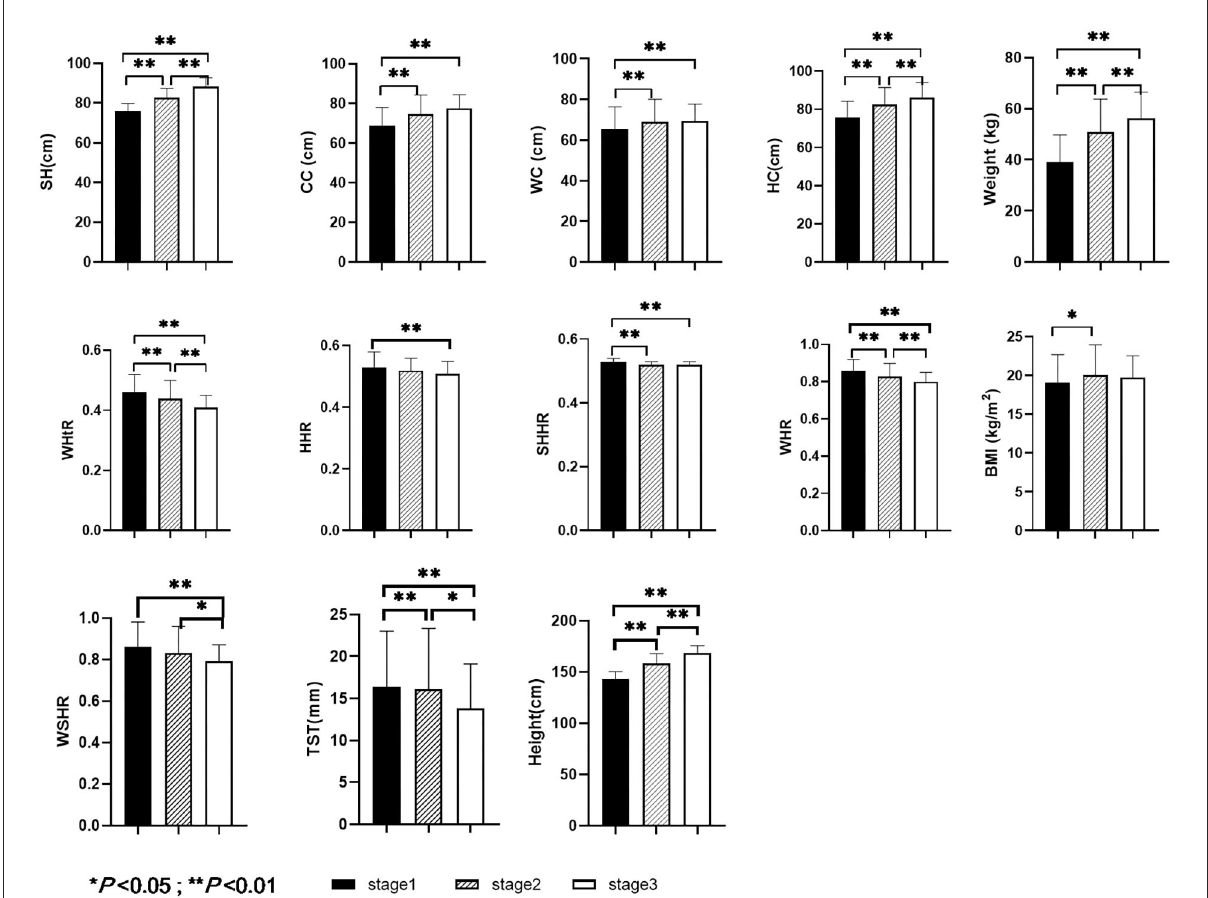
FIGURE1 Comparisons of height, SH, CC, WC, HC, WHtR, HHR, SHHR, WHR, BMI, WSHR, TST, and weight among boys with different pubertal development